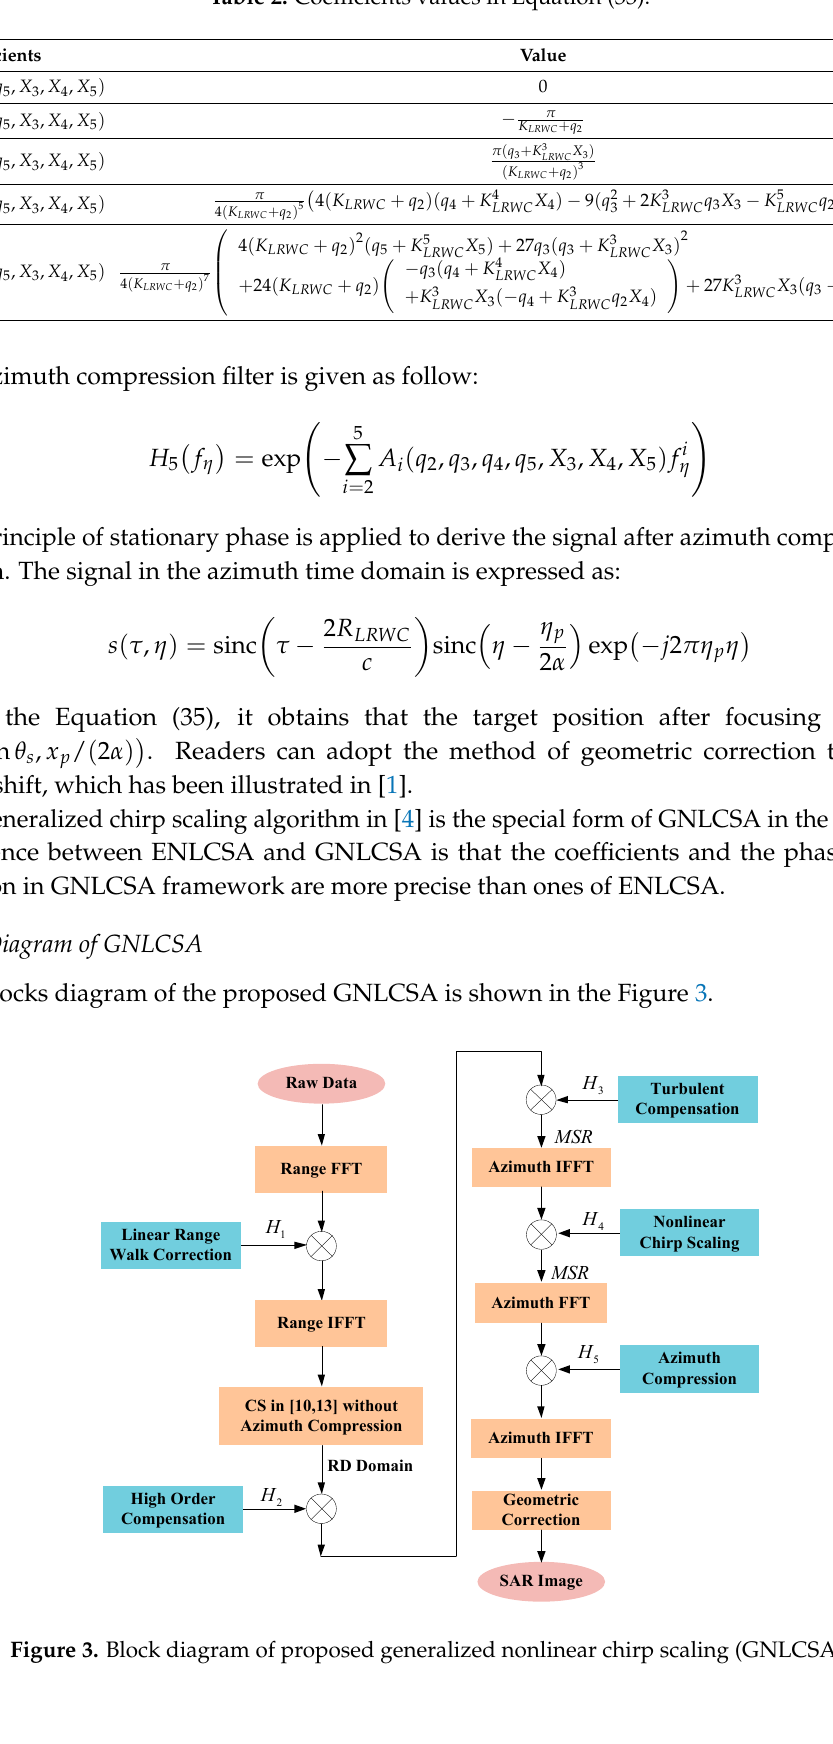
Table 2. Coefficients values in Equation (33).